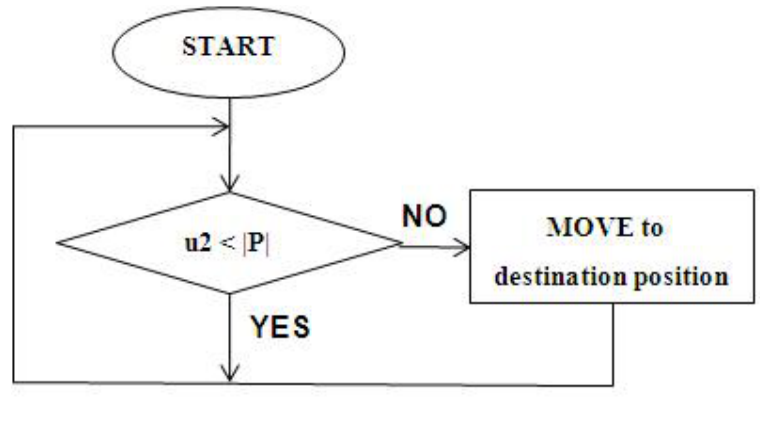
Figure 8. Flow diagram of path following controller.